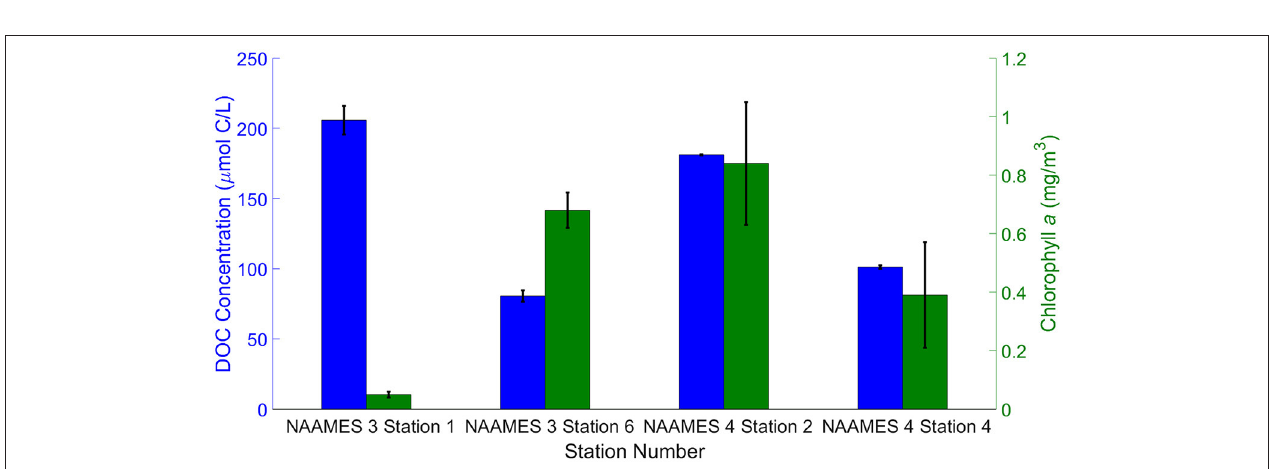
FIGURE 5 | Station averaged dissolved organic carbon (DOC) and chlorophyll a concentrations in SML samples. The blue and green bars represent the DOC concentrations and chlorophyll a concentrations, respectively. The black lines on each blue and green bar represent the standard deviation across measurements of DOC and chlorophyll a at each